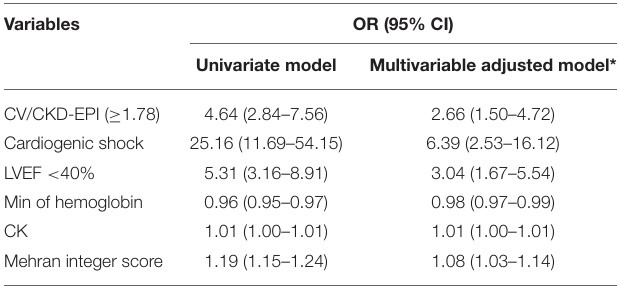
TABLE 3 | Multivariable logistics model association between CIN and CV/CKD-EPI